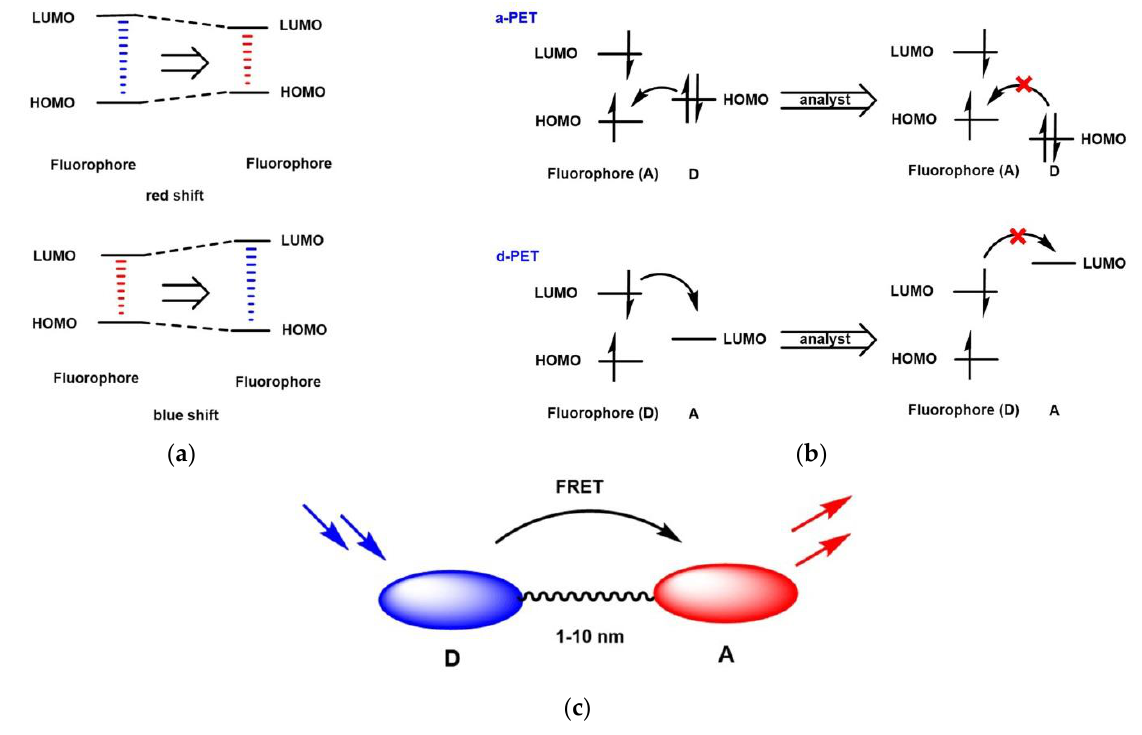
Figure 1. The mechanism of ( a ) ICT; ( b ) PET; ( c ) FRET.